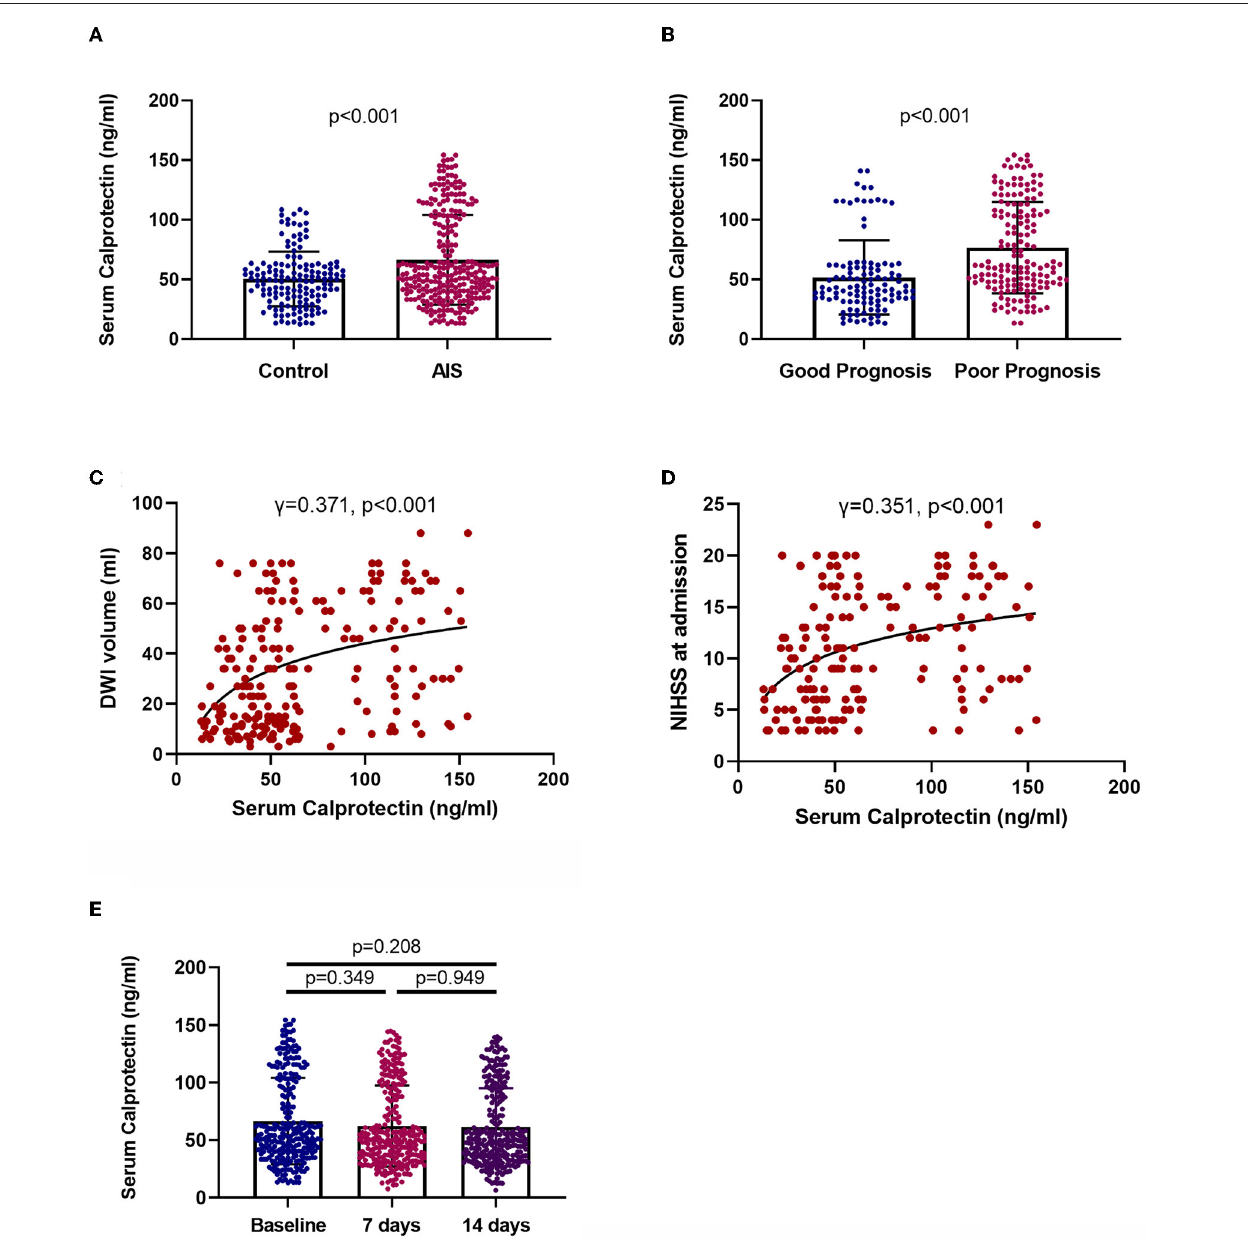
FIGURE 2 | Levels and clinical relevance of plasma calprotectin in AIS. (A) Plasma calprotectin levels in patients with AIS and controls. Unpaired t -test. (B) Plasma calprotectin levels in patients with AIS with good and poor prognosis. Poor outcome is defined as mRS ≥ 3 or death. Unpaired t -test. (C) Association between plasma calprotectin levels and diffusion-weighted imaging (DWI) hyperintensity volume at baseline. Spearman correlation analysis. (D) Association between plasma calprotectin levels and National Institutes of Health Stroke Scale (NIHSS) scores at baseline. Spearman correlation analysis. (E) Dynamic change of serum calprotectin during the 2-week follow-up after AIS. One-way ANOVA.